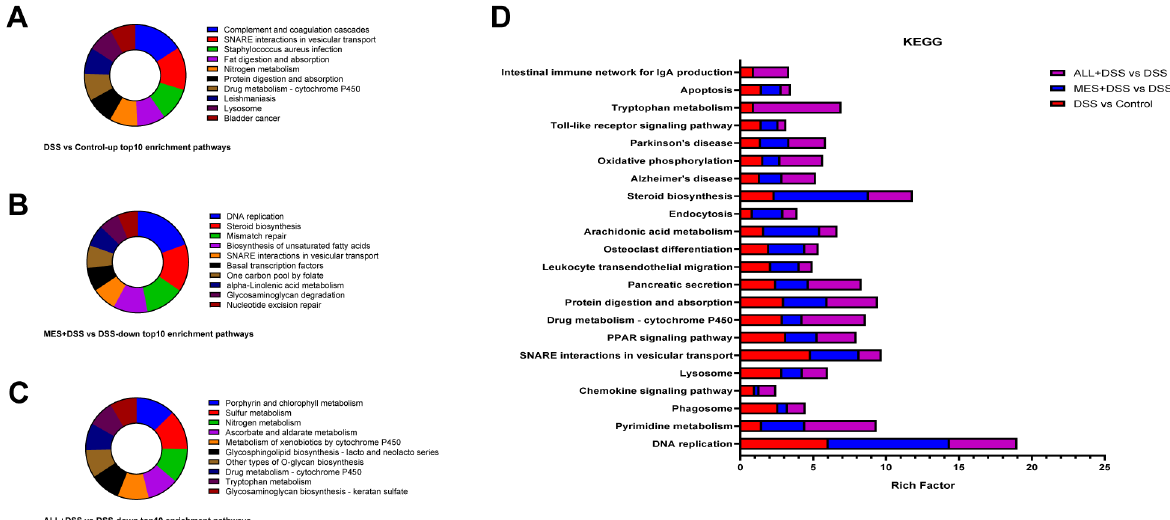
Figure 6. Distribution of prominent enrichment pathways (left) and enrichment analysis of differentially expressed proteins (DEPs) in the KEGG metabolic pathway (right). ( A – C ) Pie charts showing the top 10 enrichment pathways in different treatments compared with DSS. ( D ) The y-axis represents pathway terms, and the x-axis corresponds to the rich factor.